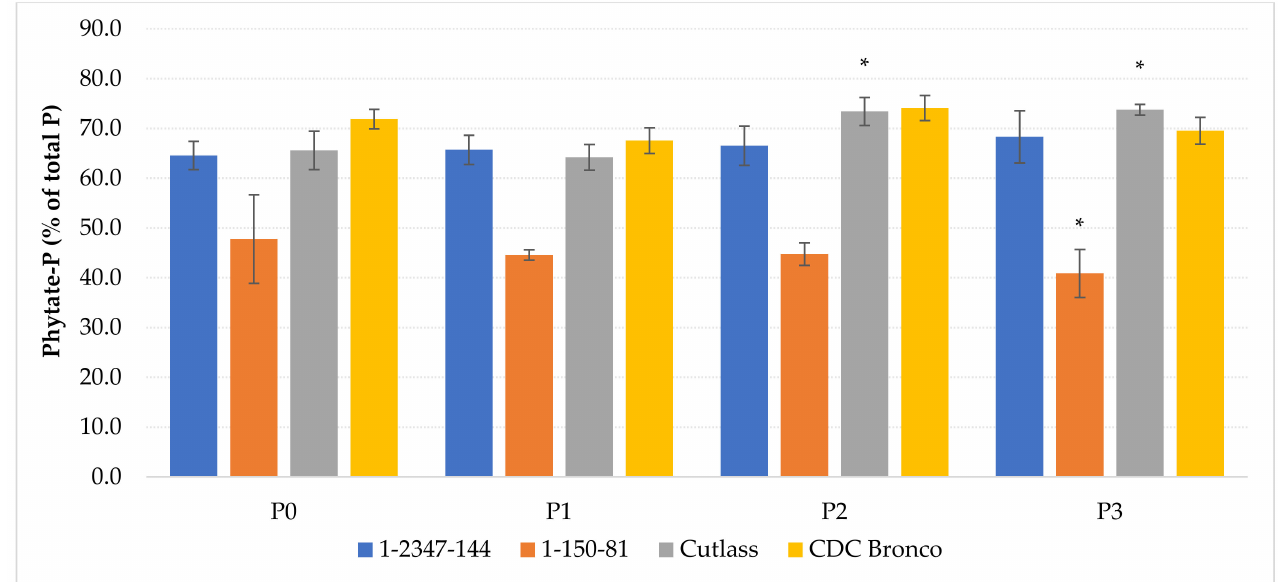
Figure 2. The effect of foliar phosphorus application on portion of phytate-P amount to the total P content in seeds. The mean values ( n = 8) marked with an asterisk are significantly different (* p ≤ 0.05) from the variant without P fertilization (P0) by the Fisher’s LSD test (each of the genotypes was statistically evaluated separately). Error bars represent the standard deviation of arithmetical mean